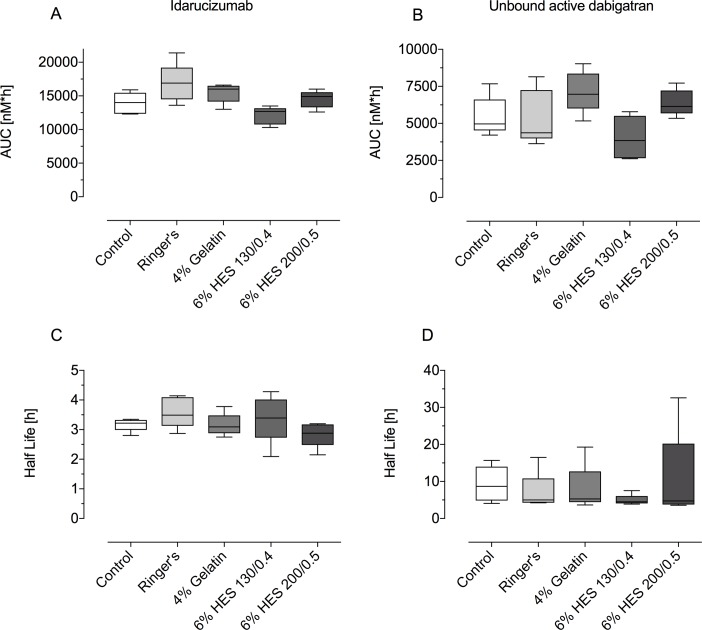
Comparison of AUC0-24 and half-life of idarucizumab (A, C) and unbound dabigatran (B, D) across the treatment groups. Data are shown as median values; boxes extend from 25th to 75th percentiles and whiskers show minimum and maximum values (n = 5/group).